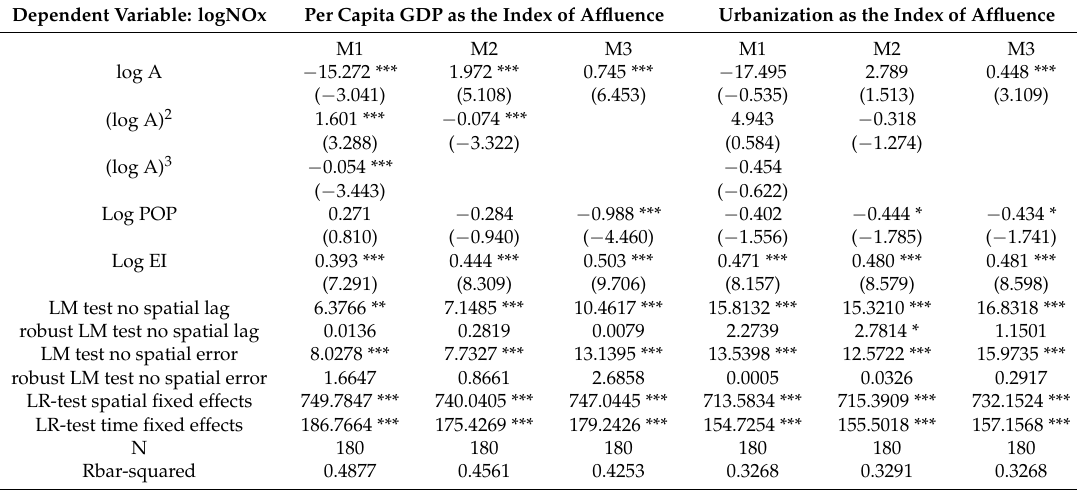
Table 3. Parameter estimates of the non-spatial panel model.